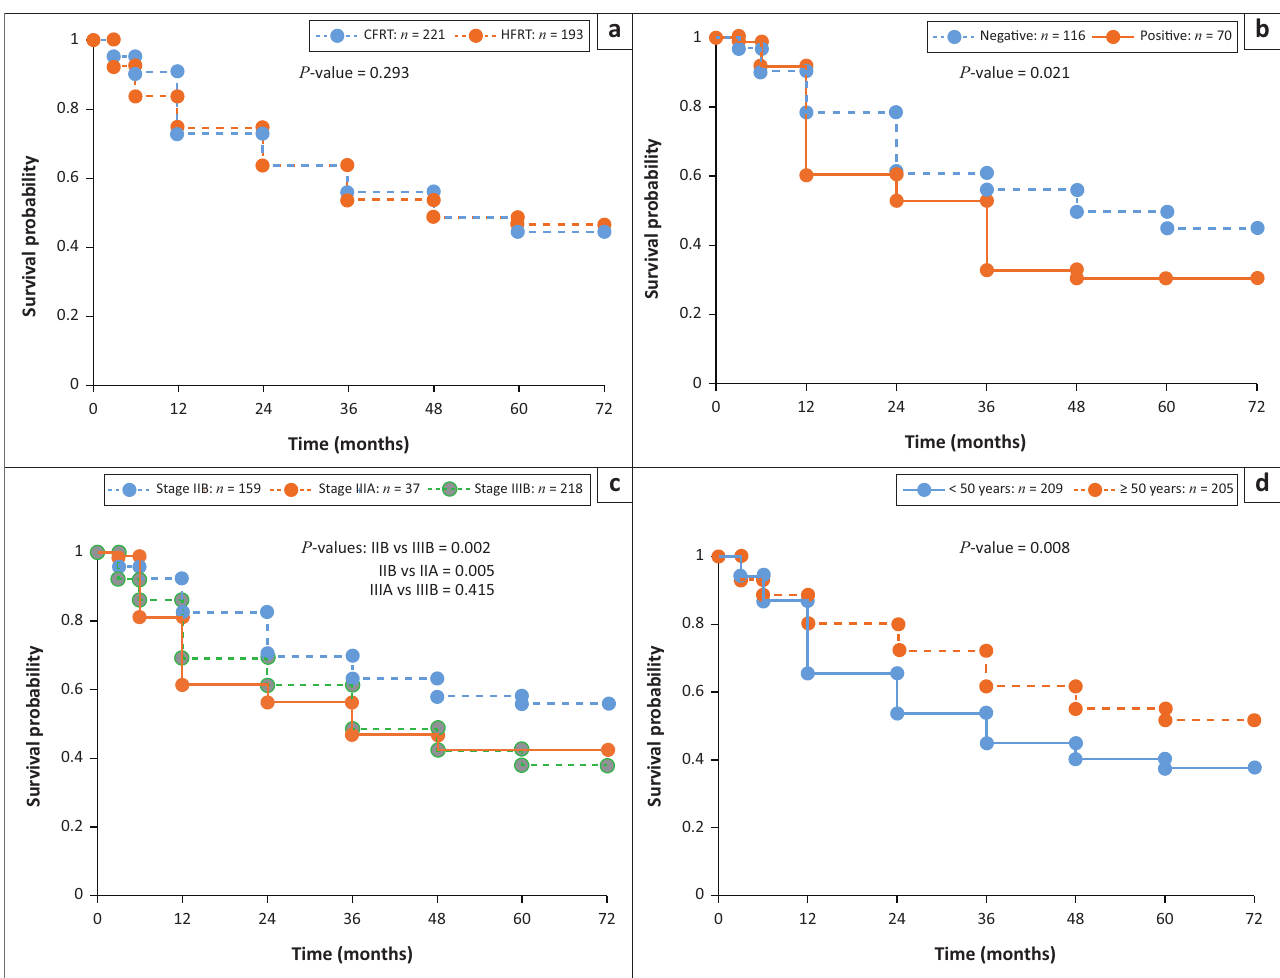
FIGURE 2: Kaplan–Meier survival probability comparison for (a) CFRT versus HFRT, (b) HIV negative versus positive, (c) FIGO stage IIB, IIIA, IIIB (d) age < 50 versus ≥ 50 TABLE 4: Comparison of stage according to patients’ age at presentation. Columns by: Stage at presentation